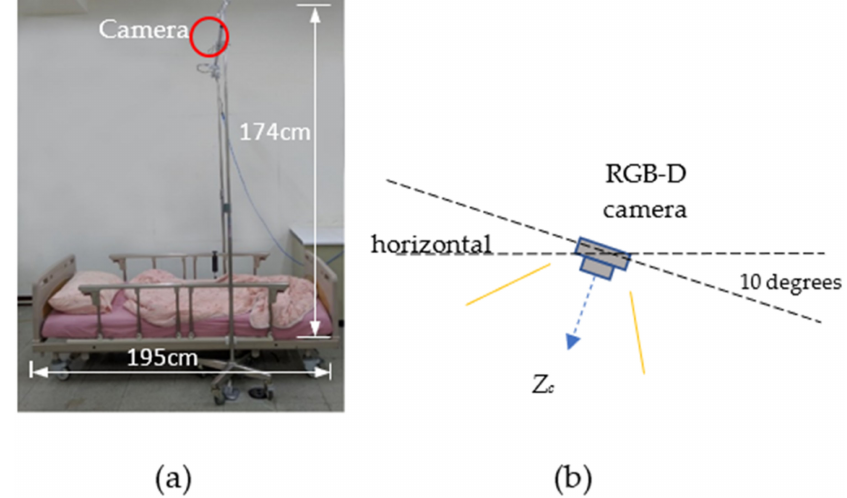
Figure 2. ( a ) The system setup; ( b ) the camera tilting angle.